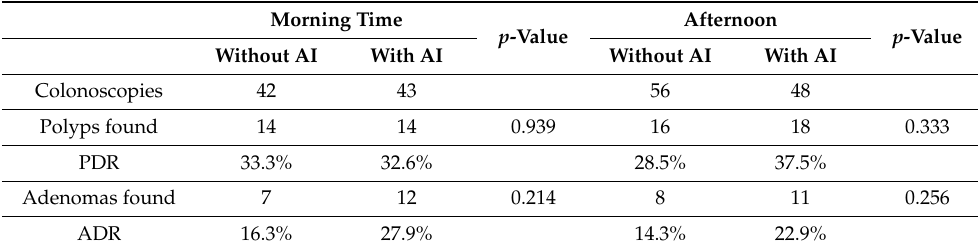
Table 2. The results of DR 1 examinations.